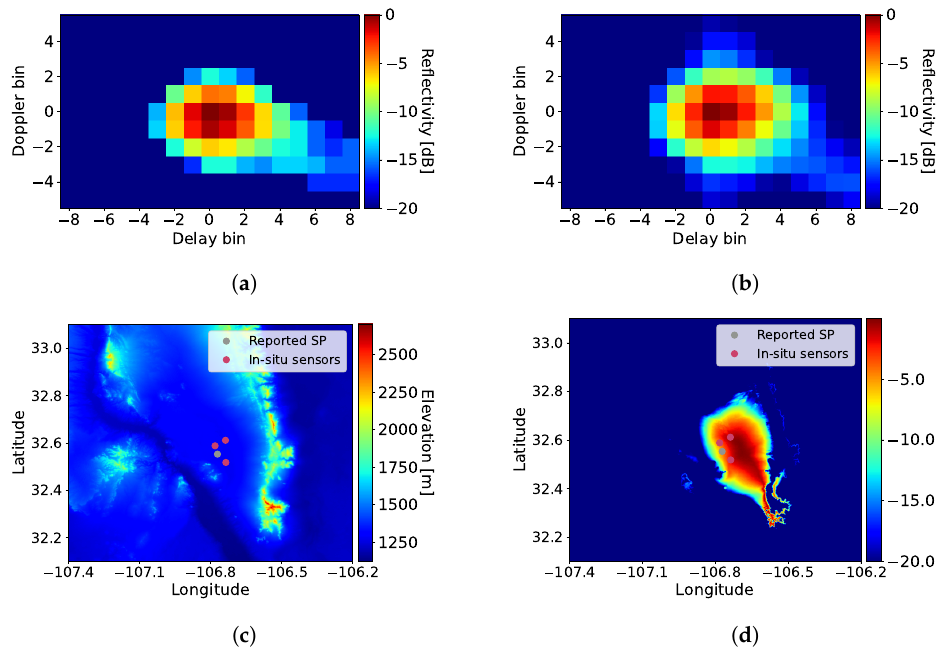
Figure 12. DDM of sample 104,027 of JER track 1: ( a ) Normalized CYGNSS DDM; ( b ) Normalized IGOT DDM; ( c ) DEM; ( d ) WAF projection of DDM cell (0,